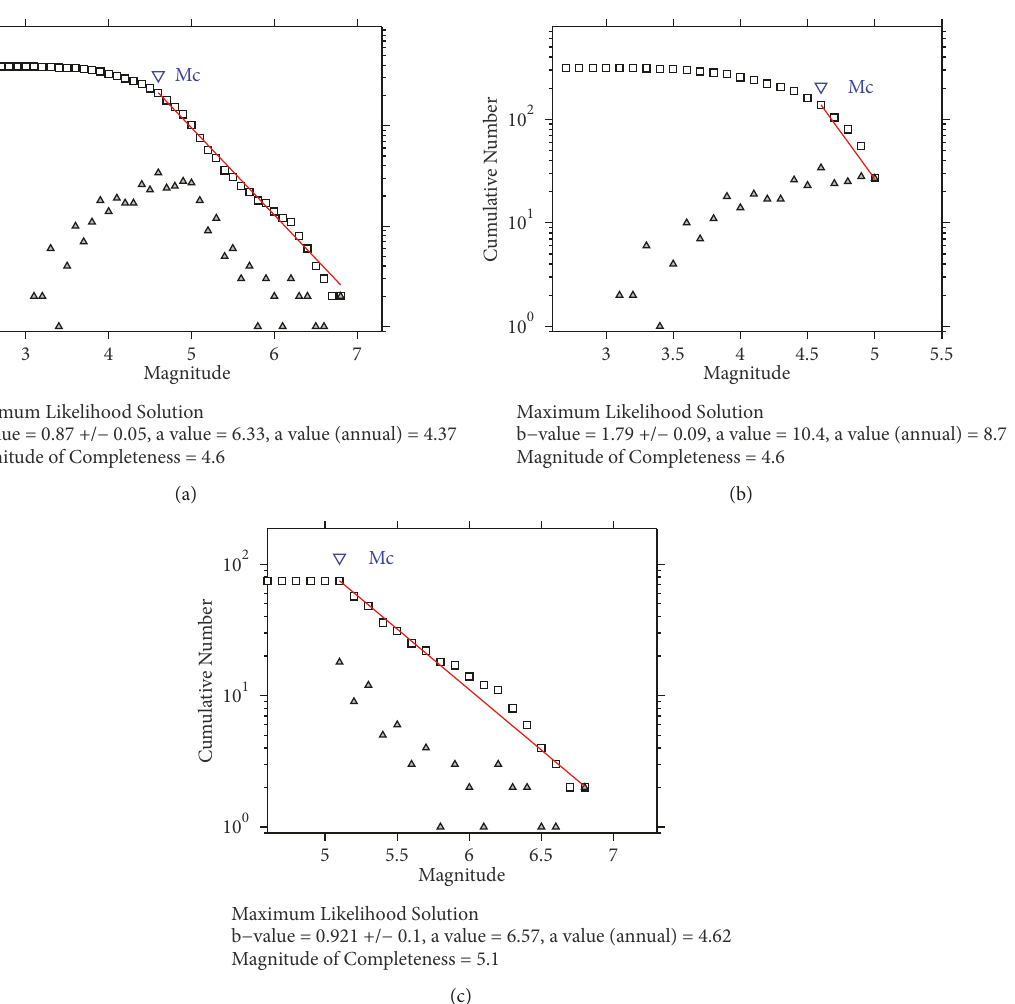
Figure 13: Magnitude distribution graph of seismicity for cluster 3 (Sumba island and surrounding areas): (a) for mb > 3 SR, (b) for mb = 3-5 SR, and (c) for mb > 5 SR.